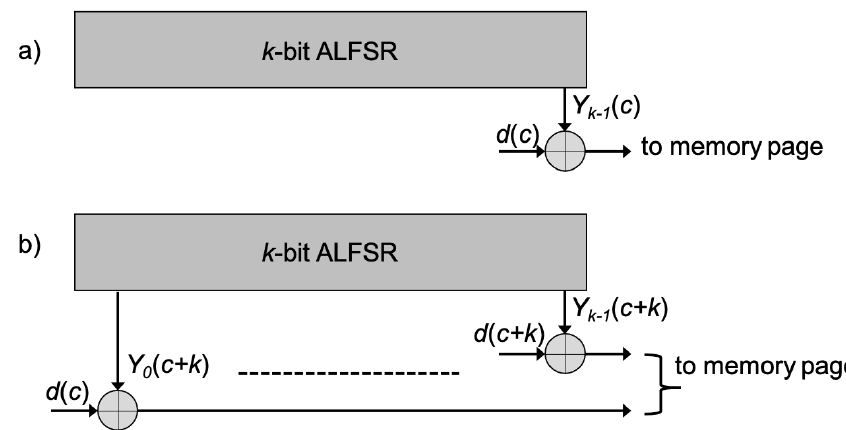
Figure 3. Possible schemes used to randomize data in a memory page. ( a ) at any clock cycle c